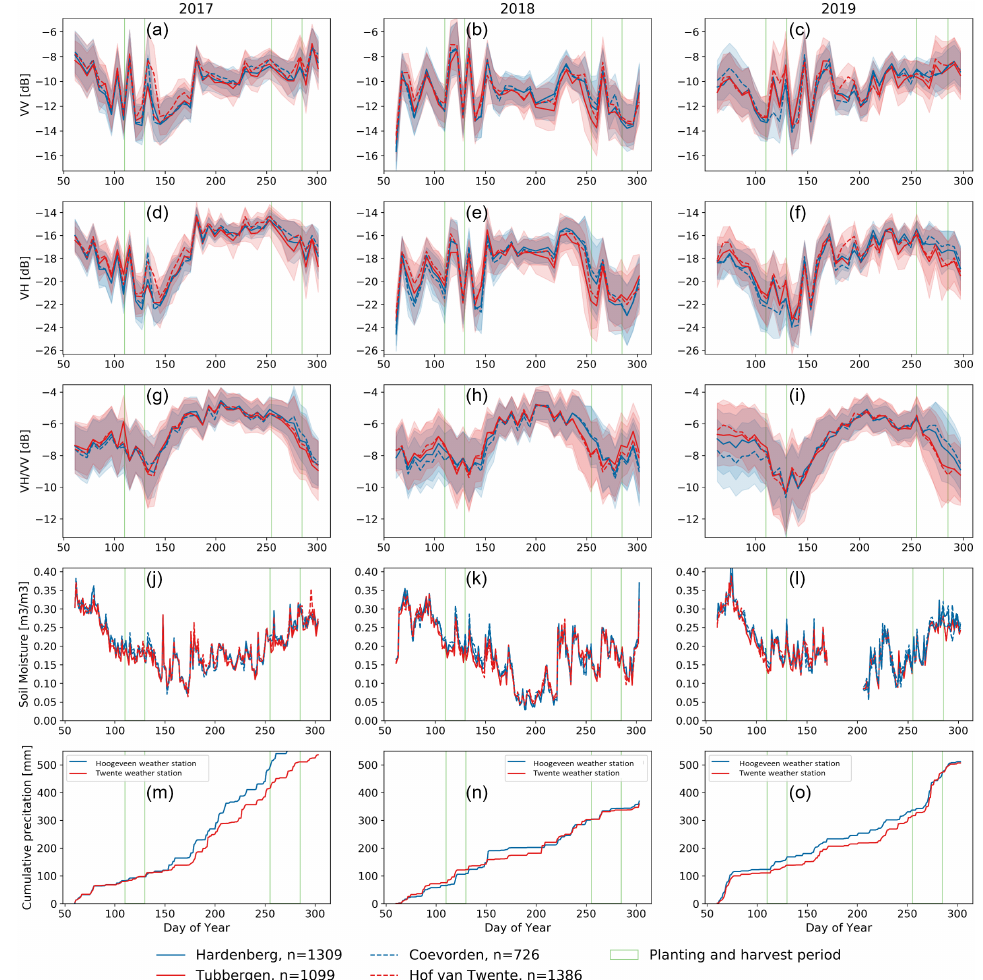
Figure 8. The 2017, 2018 and 2019 time series of Sentinel-1 SAR data (VV ( a – c ), VH ( d – f ) and VH/VV ( g – i )) from maize parcels in the Coevorden, Hardenberg, Tubbergen and Hof van Twente municipali- ties. The shaded areas indicate the standard deviation calculated across all parcels. Spatially averaged soil moisture ( j – l ) for each municipality and cumulative precipitation ( m – o ) from Hoogeveen and Twente weather stations. Vertical green lines indicate crop sowing and harvesting